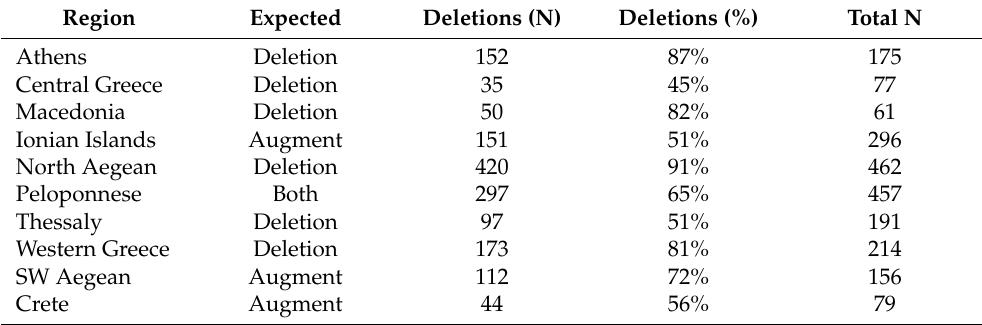
Table 5. Distribution of the deletion of the unstressed syllabic augment among CG speakers by region of origin (N =